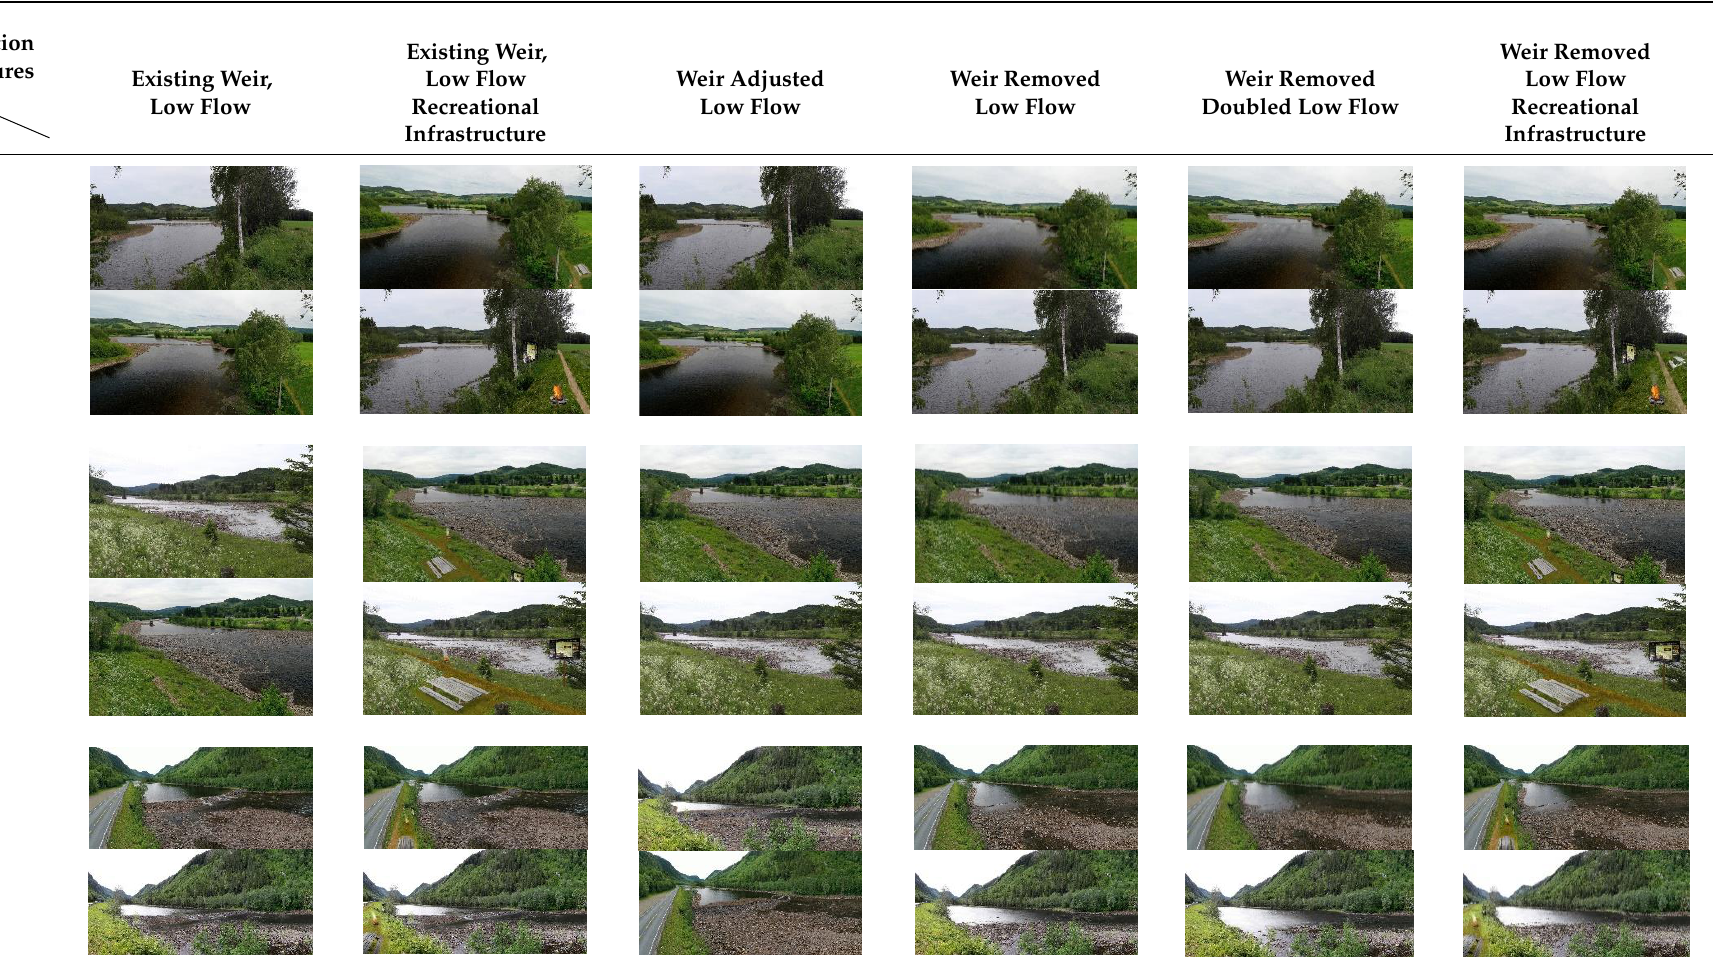
Table 3. Visual scenarios of environmental measures.